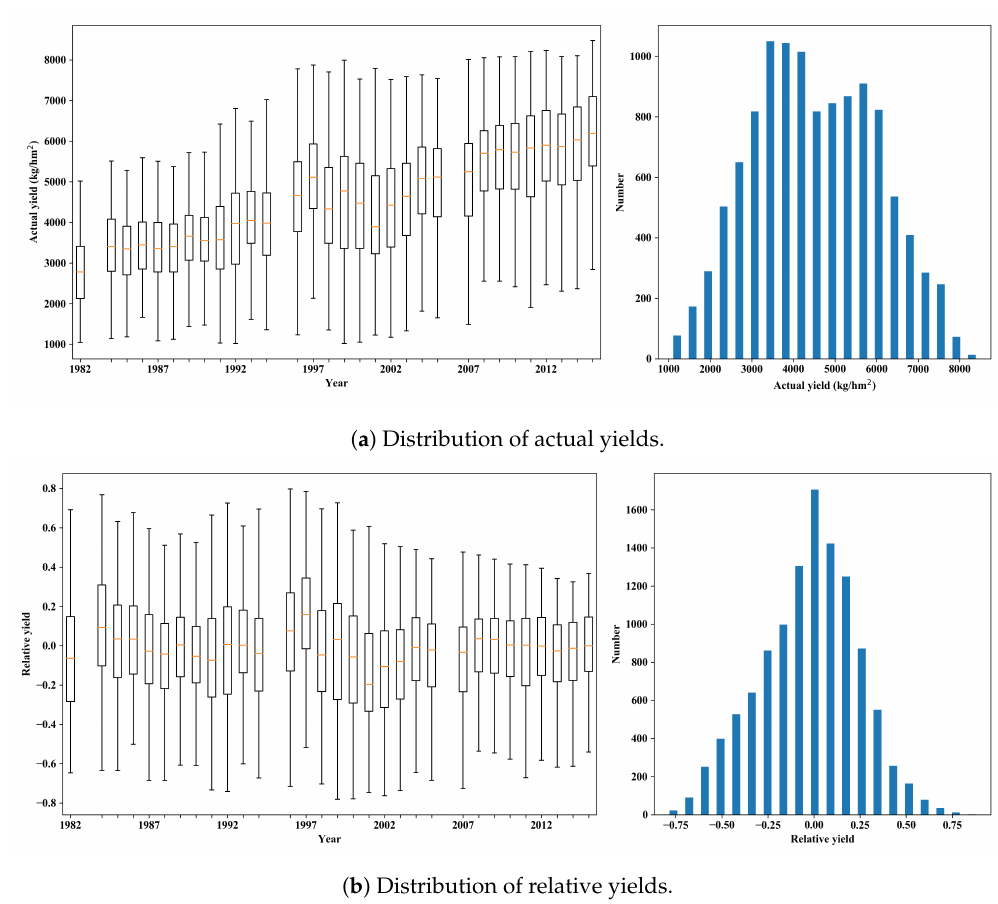
Figure 3. A comparison between the distributions of actual wheat yields and relative yields from 1982 to 2015 in central